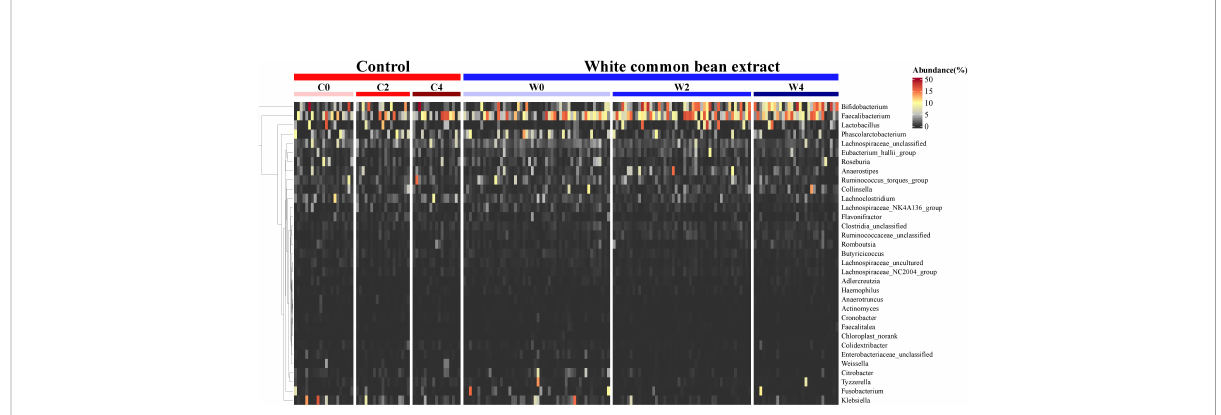
FIGURE 5 The dynamic change in key OTU abundance during the intervention in both groups. The abundance of the OTUs identi fi ed based on LEfSe by comparing the two groups 2 months and 4 months post-intervention and the same group before and after the intervention were used to illustrate the dynamic variation of the key taxa during the a - glycosidase inhibitor